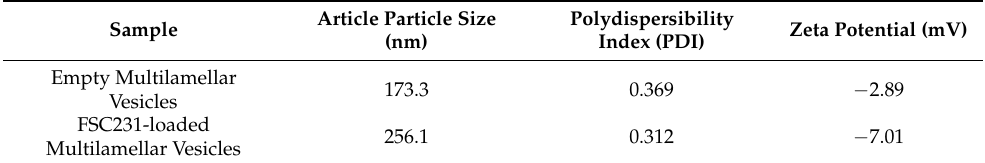
Table 1. Summary of size distribution results. Empty MLVs had an average particle size of 173 nm,